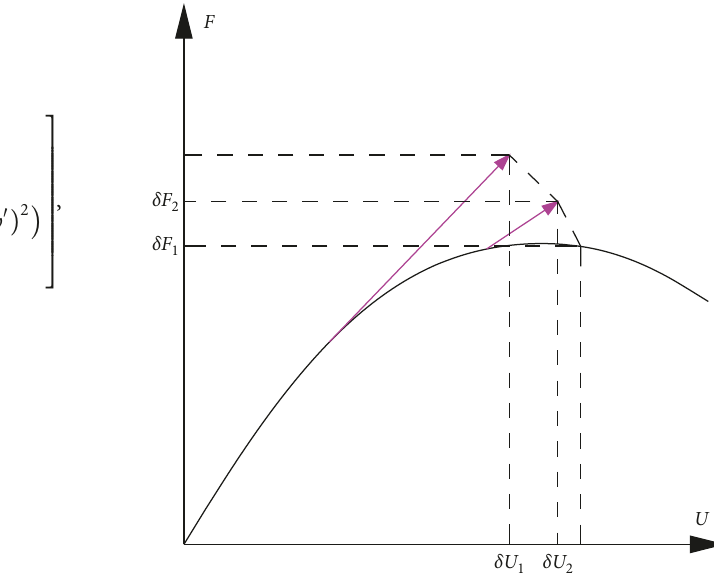
Figure 11: Scheme of the Crisfield